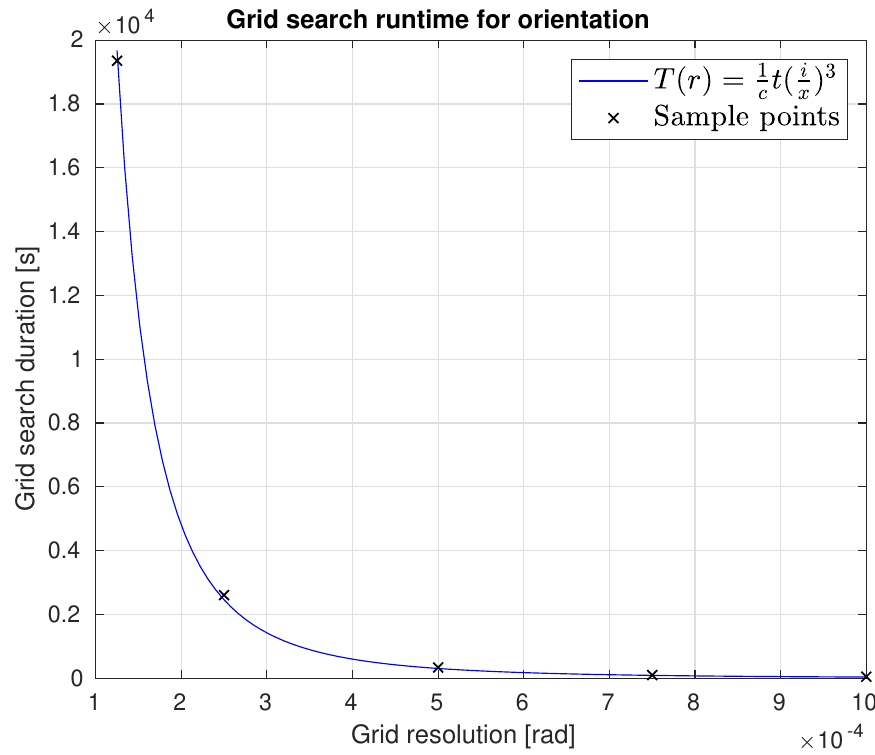
Figure 9. The plot shows the runtime behavior of the grid search with respect to the grid resolution. The curve in the graph is an approximation to the grid search durations in Table